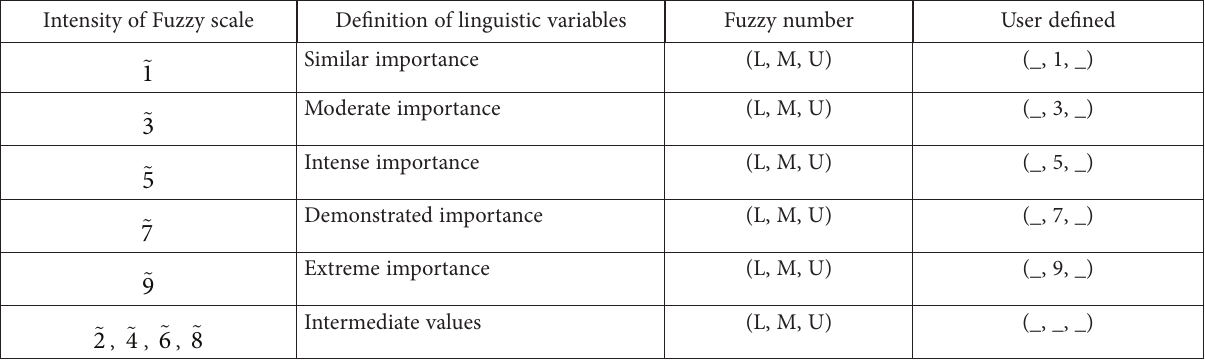
Table 4. Pair-wise comparison of linguistic variables using fuzzy numbers (source: Buckley, 1985) Intensity of Fuzzy